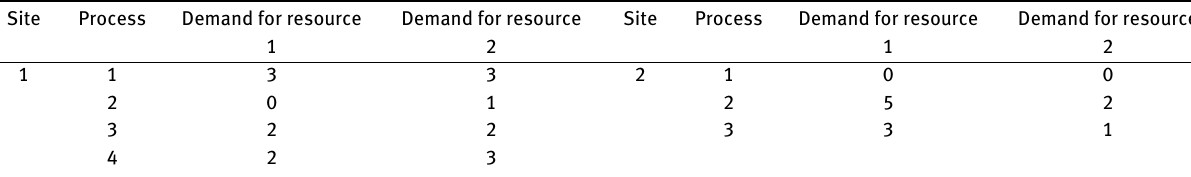
Table 2: Number of resource units necessary to execute construction processes - resource reservation option. Site